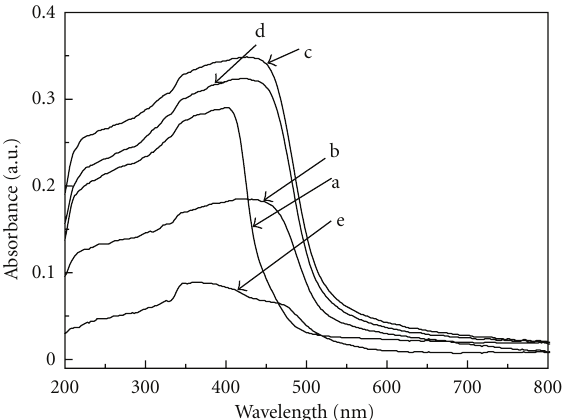
Figure 4: DRS spectra of samples under di ff erent pH at 110 ◦ C. (a) pH = 1.0, (b) pH = 3.0, (c) pH = 5.0, (d) pH = 7.0, (e) pH = 10.0.